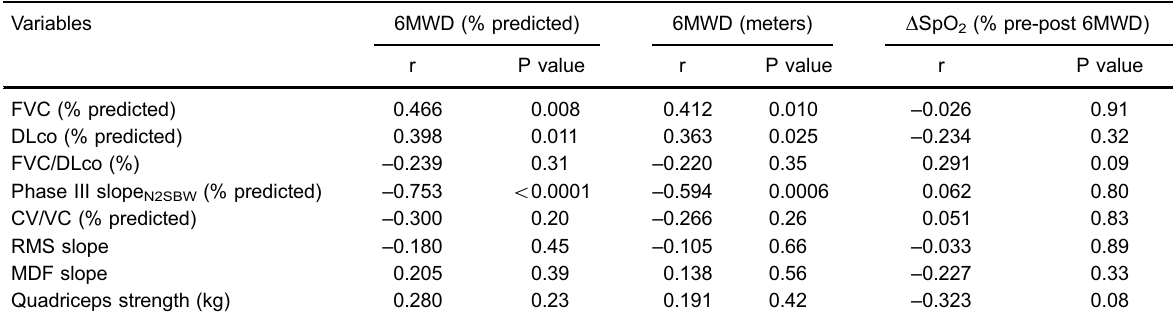
Table 2. Spearman ’ s correlation coef fi cients for the 6-min walking distance and peripheral oxygen saturation with lung function and peripheral muscle parameters.